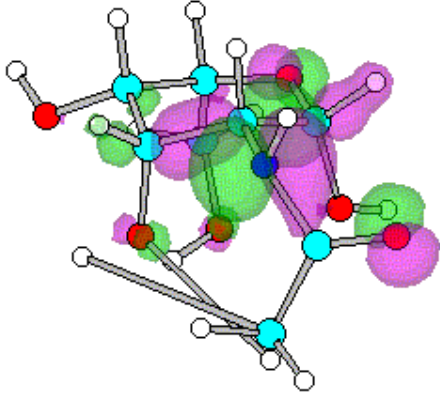
Figure 3. Optimized geometry and spatial distribution of HOMO for N-acyl-AG (2).